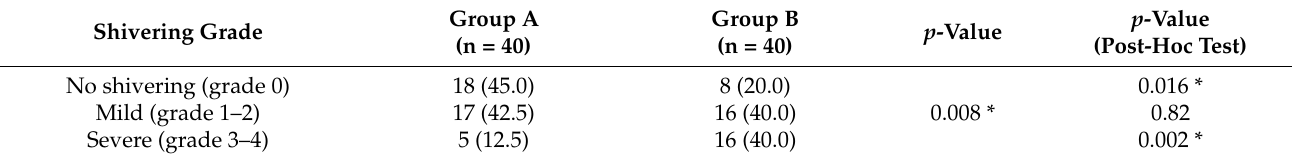
Table 2. Highest shivering grade after 15 min of subarachnoid block.